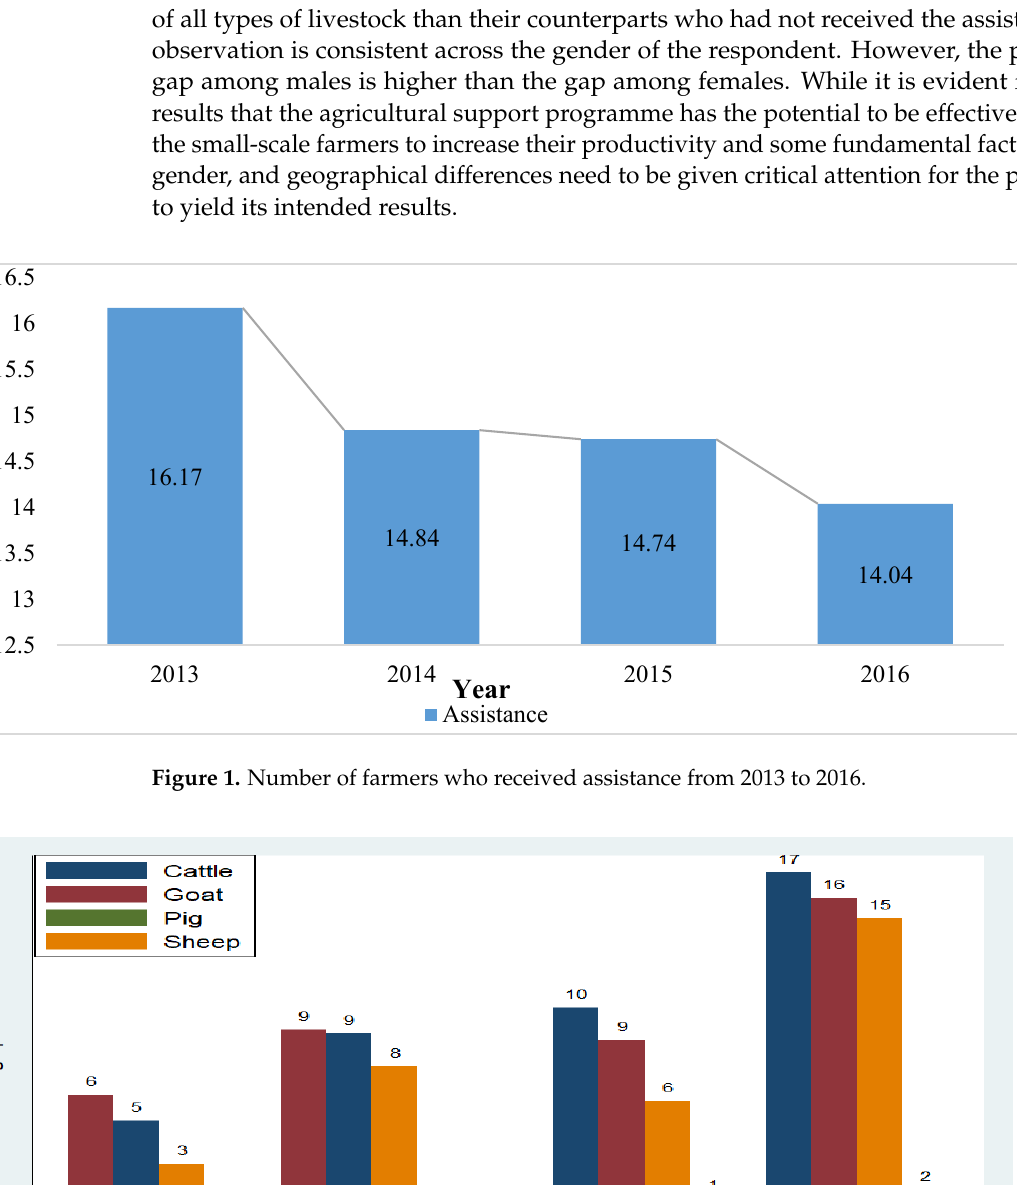
Figure 3. Average livestock production by gender and assistance status of the respondent. As expected, the gender inequality in earnings from agricultural activities is depicted in Figure 4, and this is consistent across all the survey periods. The gap has been widening to the extent that, since 2015, the average income of males who were assisted was more than twice that of their female counterparts. Considering the respondents who never re- ceived any support, the gap is relatively lower compared to those who were assisted. These trends support the assertions made in the preceding paragraphs that there is the need for gender mainstreaming in the implementation of the programme to ensure that it does not worsen the already existing inequalities among the small-scale farmers.